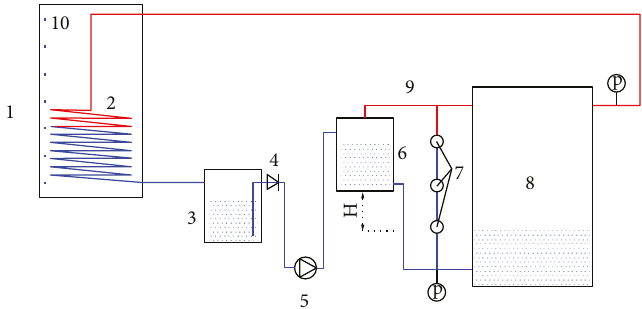
Figure 1: Schematic of the forced-circulation wickless LT-SWH system. (1) Water tank, (2) condensation spiral coil pipe, (3) condensation liquid storage tank, (4) check valve, (5) refrigerant pump, (6) evaporation liquid storage tank, (7) sight glass, (8) evaporation solar collector, (9) pressure balance pipe, (10)